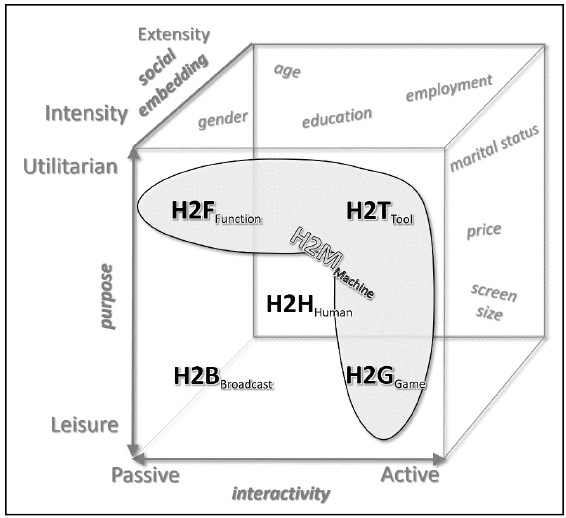
Figure 1. Polymodal media taxonomy of mobile apps along three axes: interactivity = horizontal; purpose = vertical; social embedding = depth.